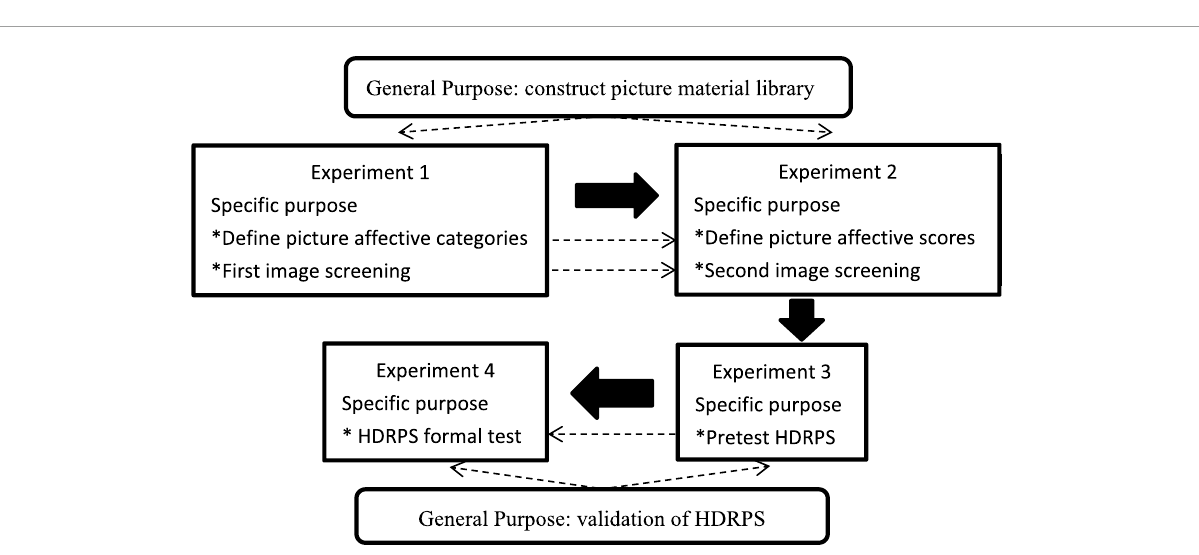
FIGURE2 Experimental procedure and purpose. The dotted lines represent the intrinsic link between the experiment objectives, and the solid arrows indicate the study order.